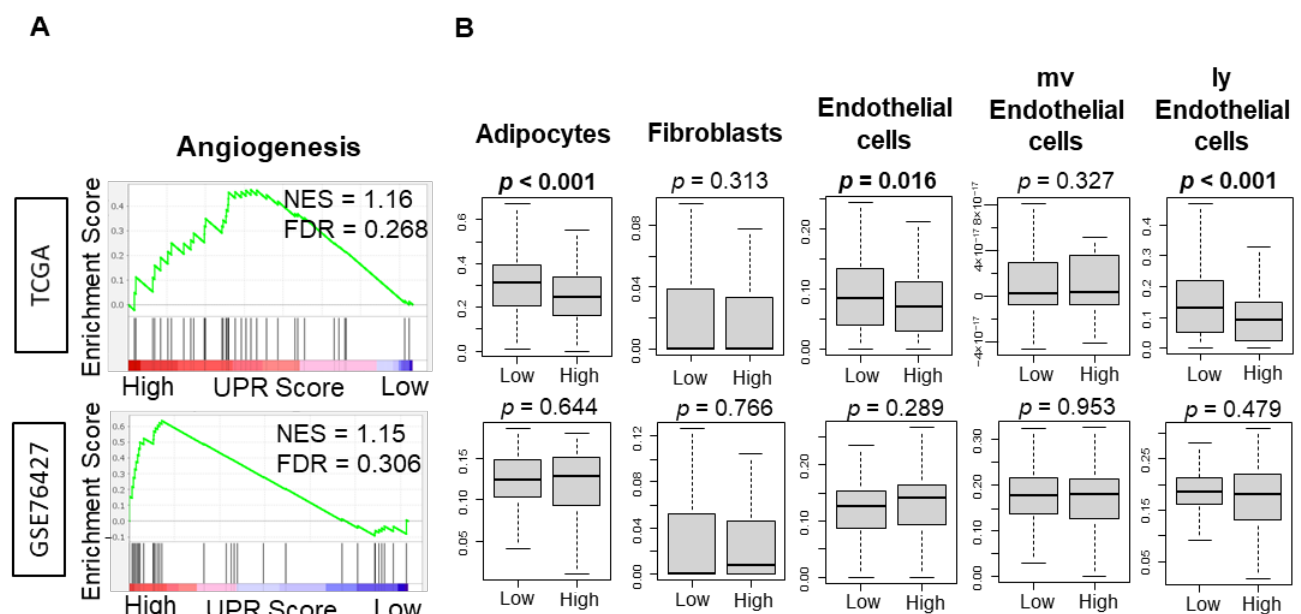
Figure 5. Association between Unfolded Protein Response and angiogenesis in the TCGA and GSE76427 cohorts. ( A ) Enrichment plots with the normalized enrichment score (NES) and false discovery rate (FDR) for the angiogenesis gene sets of the Hallmark gene sets. ( B ) Boxplots of the angiogenesis related gene sets adipocytes, fibroblasts, endothelial cells, mother vessel (mv) endothelial cells, and lymphatic (ly) endothelial cells. The p -value was calculated using the Mann-Whitney U test. Bold format: Significant p values.